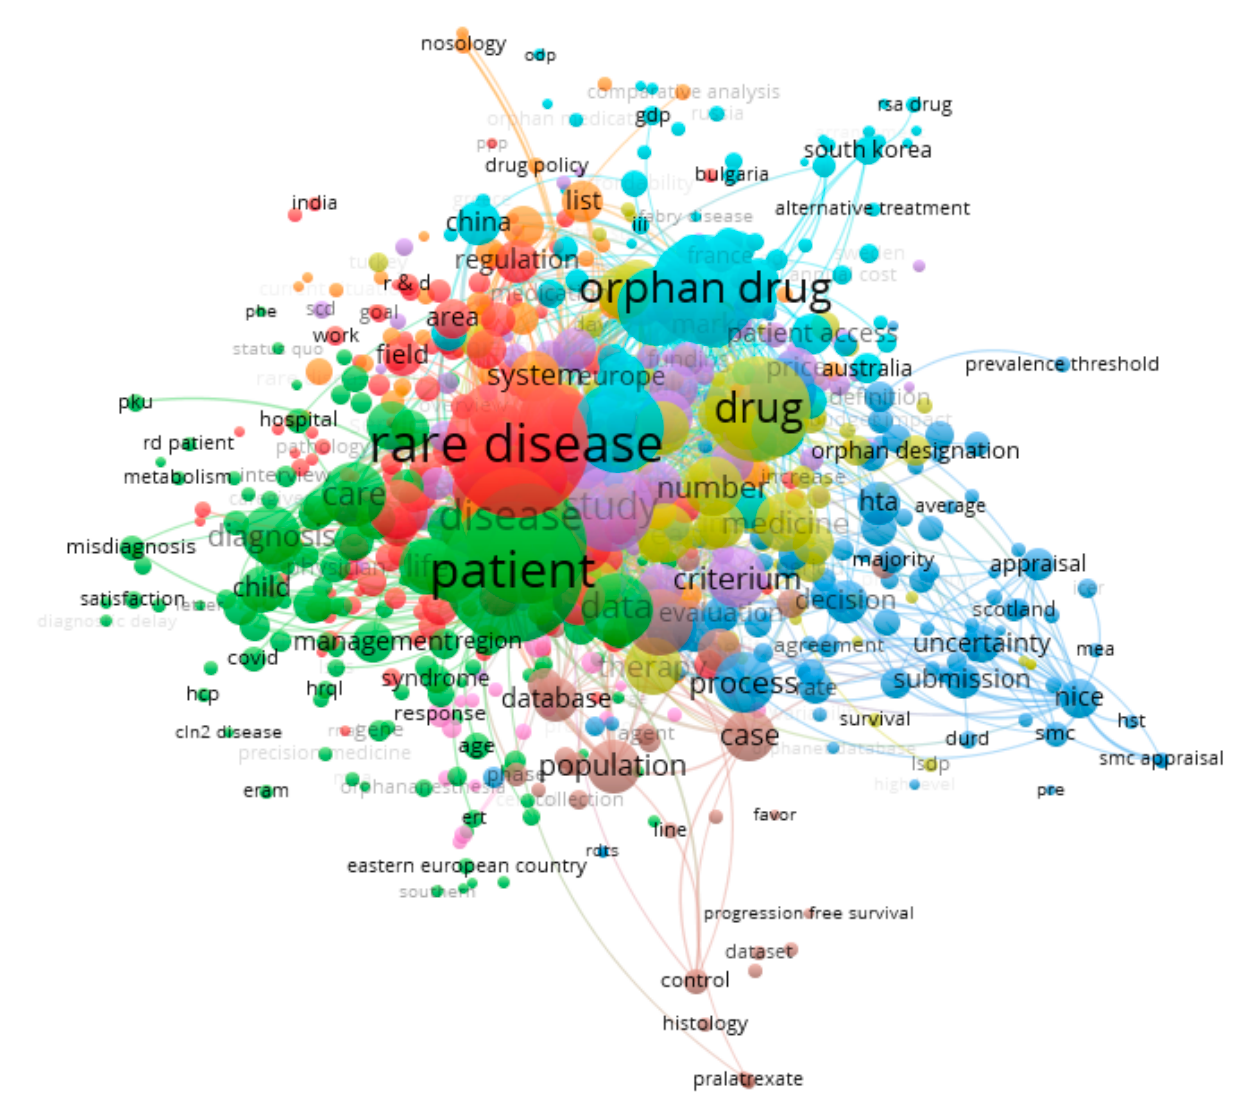
Figure 3. Mapping latent variables from titles and abstracts of the publications on issues connected with rare diseases. Note: Technical publication on mapping and clustering using VOSviewer [36,37]. Limitations: the authors did not take into account many valuable publications in the study, instead taking into account the need to narrow the thematic scope of the described issues. Source: own elaboration based on 343 references [44–386].